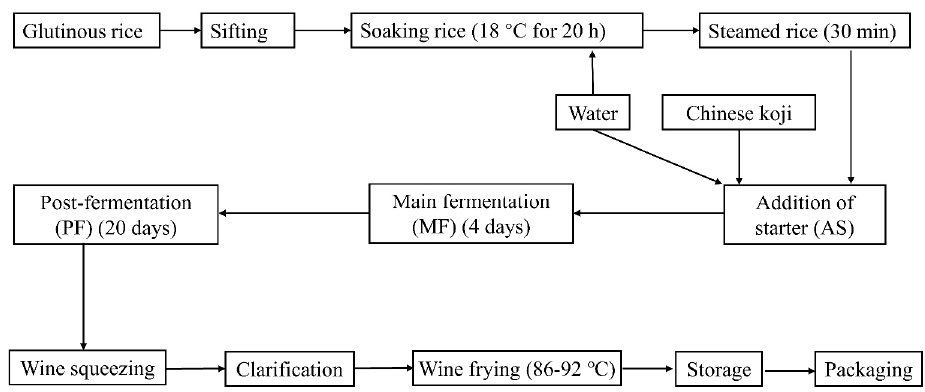
Figure 1. Diagram of the Chinese rice wine production process.